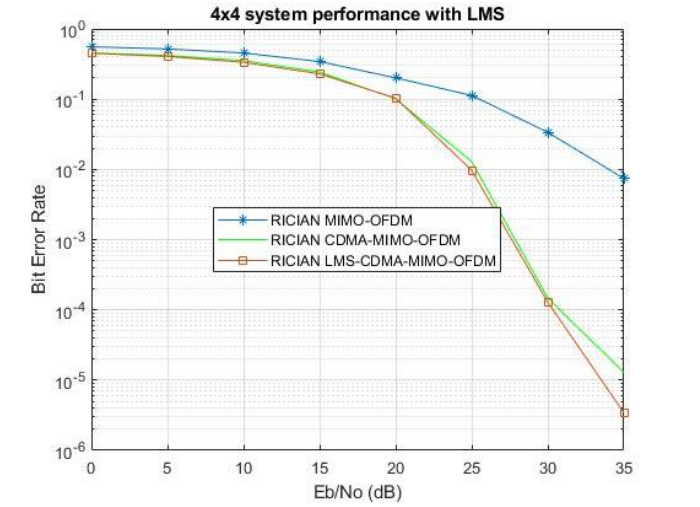
Figure 20. SNR vs. BER plot for 4×4 LMS-MIMO-OFDM model in Rician